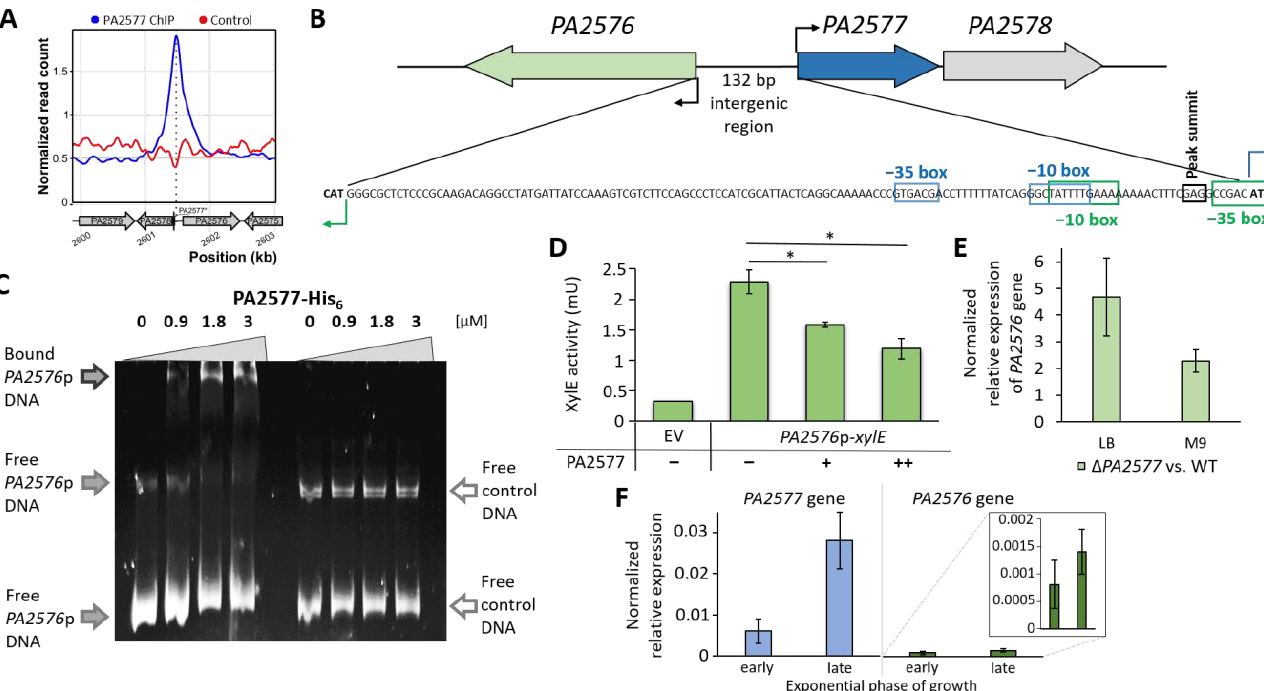
Figure 4. PA2577 interaction with DNA assayed in vivo and in vitro and its regulatory properties. ( A ) ChIP-seq signal over region encompassing PA2577 binding site in PA2576 / PA2577 divergent promoter. The plot shows normalized coverage with reads for indicated positions in PAO1161 ∆ PA2577 genome averaged for ChIP replicates. Genes are presented as grey arrows, only names of PAO1 orthologs are shown for clarity. ( B ) Schematic picture of PA2577 , PA2576 and PA2578 loci with the PA2576 / PA2577 intergenic region; -35 and -10 regions of PA2576 p and PA2577 p predicted using BPROM [43] are marked as well as the summit of ChIP-seq peak. ( C ) EMSA using PA2577-His 6 and DNA of the PA2576 promoter region; 100 ng of DNA was incubated with an increasing amount of PA2577-His 6 . Samples were separated on a 10% polyacrylamide gel; 331 bp pCM132 fragment was used as a control to rule out non-specific DNA binding. ( D ) XylE activity in E. coli DH5 α cells carrying pMEB189 ( PA2576 p- xylE ) containing pMEB64 ( tac p- PA2577 ) vector allowing PA2577 overproduction (+) or control pAMB9.37 ( − ). Strains were grown under selection in L broth. Data for cells with the promoter-less pPTOI (- xylE ) and pAMB9.37 are shown as a background control (EV). Data represent mean ± SD from three biological replicates. * indicates p -value < 0.05 in Student’s two-tailed t -test. ( E ) Fold change of PA2576 expression in ∆ PA2577 vs. WT cells grown in rich (LB) and minimal (M9) medium and harvested at OD 600 ~0.5. ( F ) Expression of PA2577 and PA2576 genes in PAO1161 in a rich medium at early (OD 600 ~0.5) and late exponential phase of growth (OD 600 ~1.5). Data represent mean ± SD from three biological replicates.